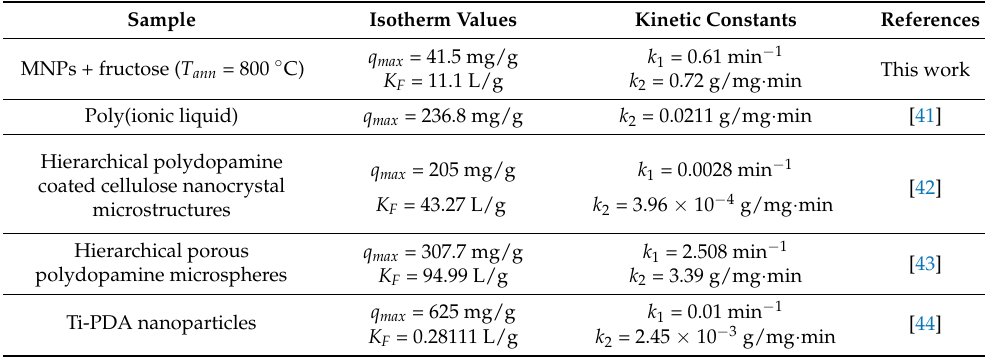
Table 5. ComparisonofmaximumCr(VI)adsorptioncapacityandkineticconstantswithreportedadsorbents.